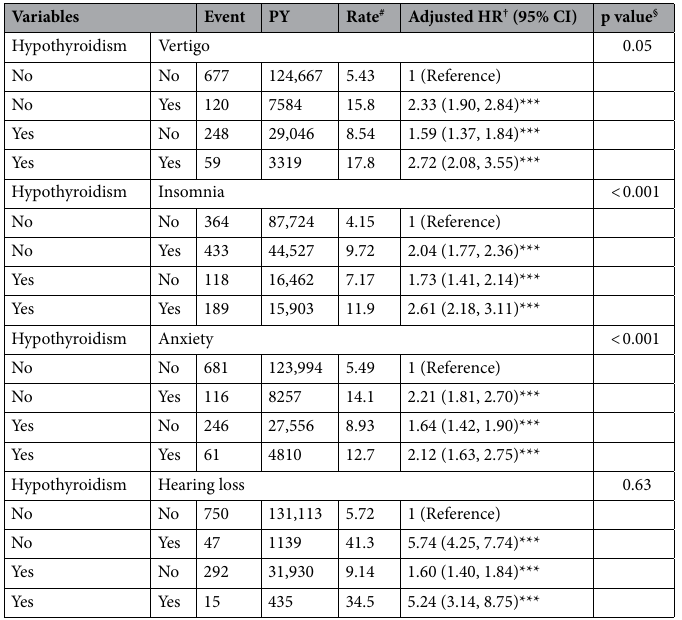
Table 4. Cox proportional hazard regression analysis for the risk of tinnitus-associated hypothyroidism with interaction of comorbidity. Adjusted HR † : adjusted for age and gender. *p < 0.05, **p < 0.01, ***p < 0.001. § p value for interaction.